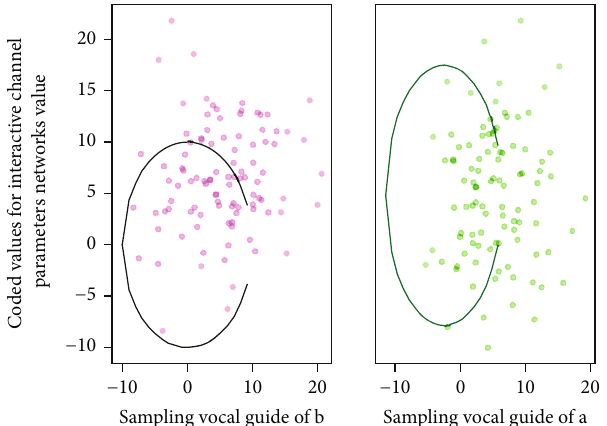
Figure 3: Coding distribution of interactive vocal guidance channel